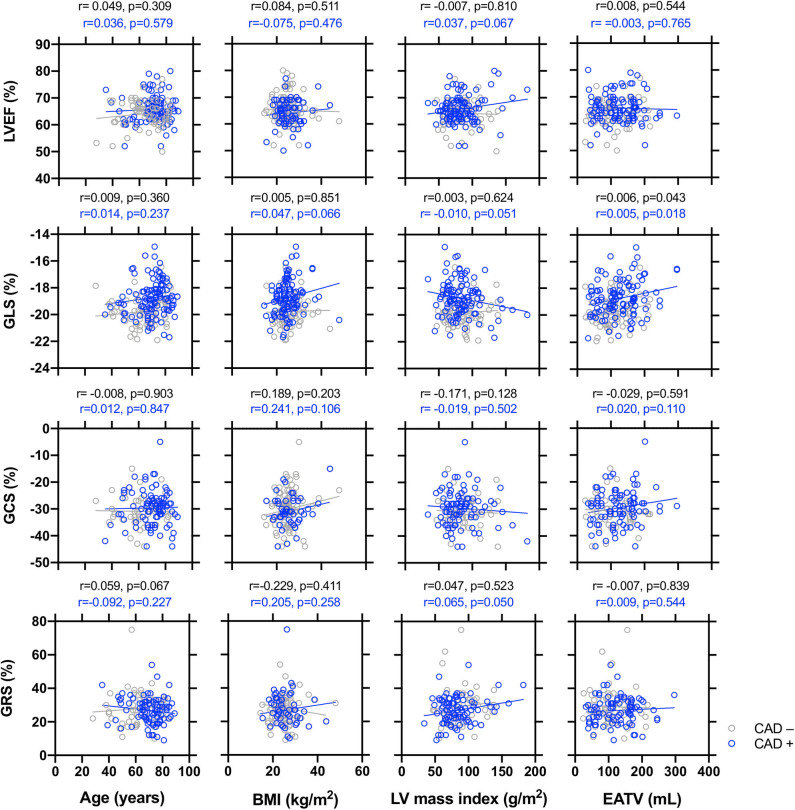
Simple correlations between the echocardiographic parameters of end systolic global longitudinal strain (GLS), global circumferential strain (GCS), and global radial strain (GRS), respectively with age, body mass index (BMI), left ventricular mass index (LVMI), and epicardial adipose tissue volume (EATV) in patients with or without coronary artery disease (CAD). A simple regression analysis was made separately in non-CAD (black circles and lines) and CAD patients (blue circles and lines). The R and P-values are shown.